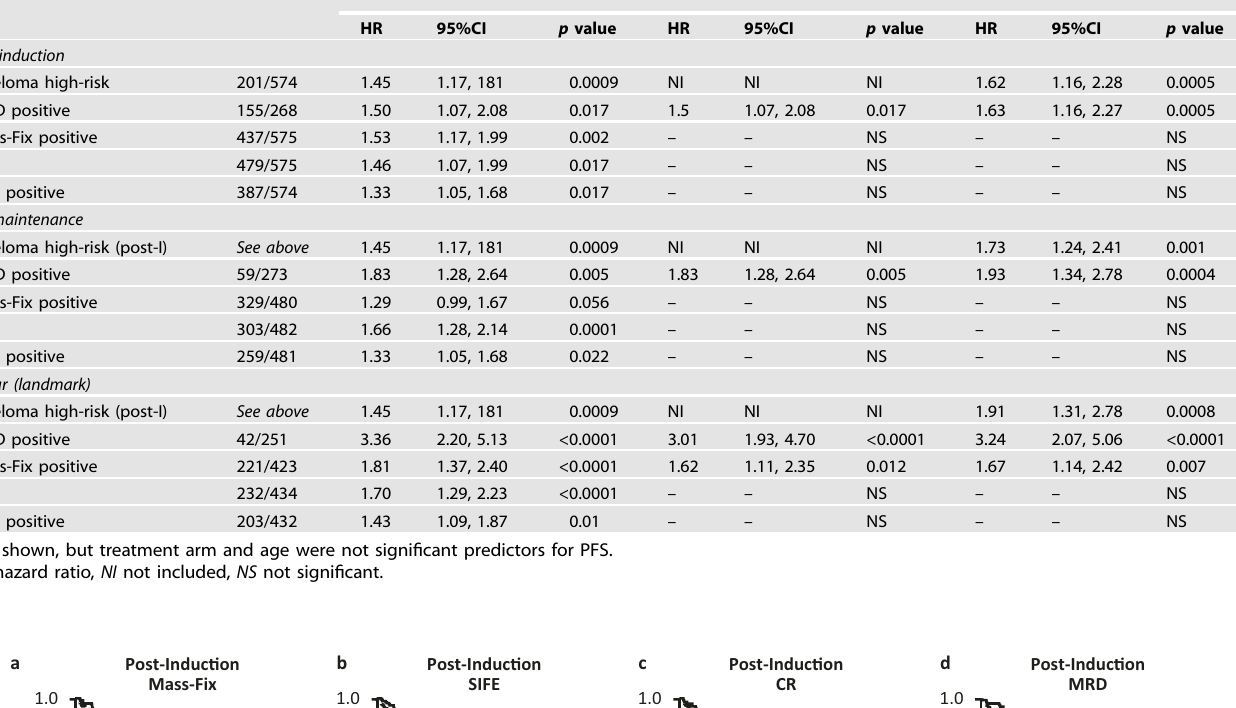
Table 2. PFS univariate and multivariate. n/N Univariate Multivariate 1 Multivariate 2